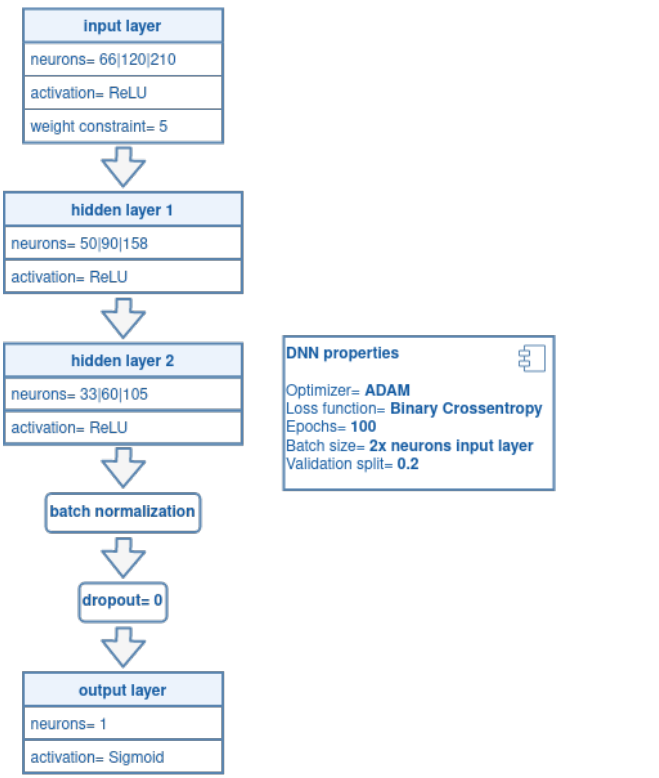
Figure 11. DNN configuration and hyper-parameters.